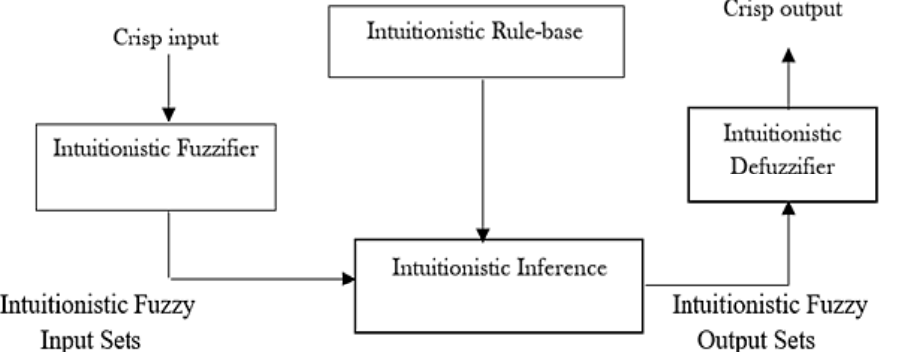
Fig. 2. Intuitionistic fuzzy logic system